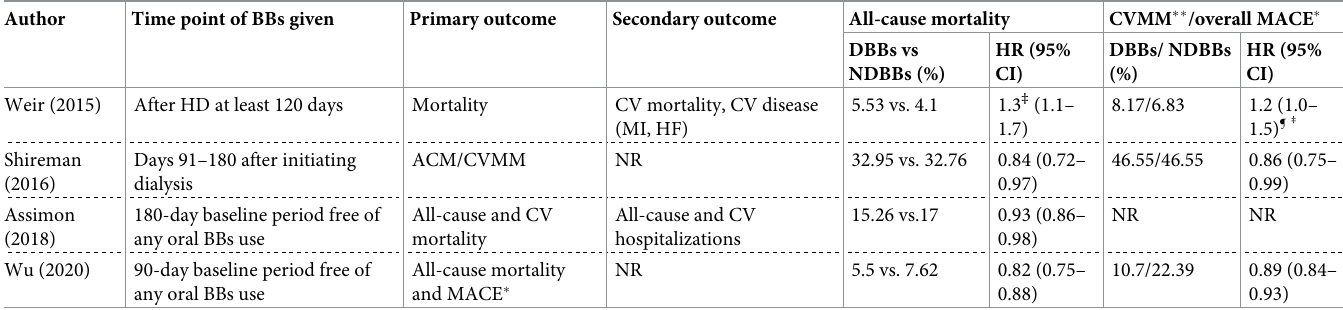
Table 2. Summary of included studies for outcome evaluation.